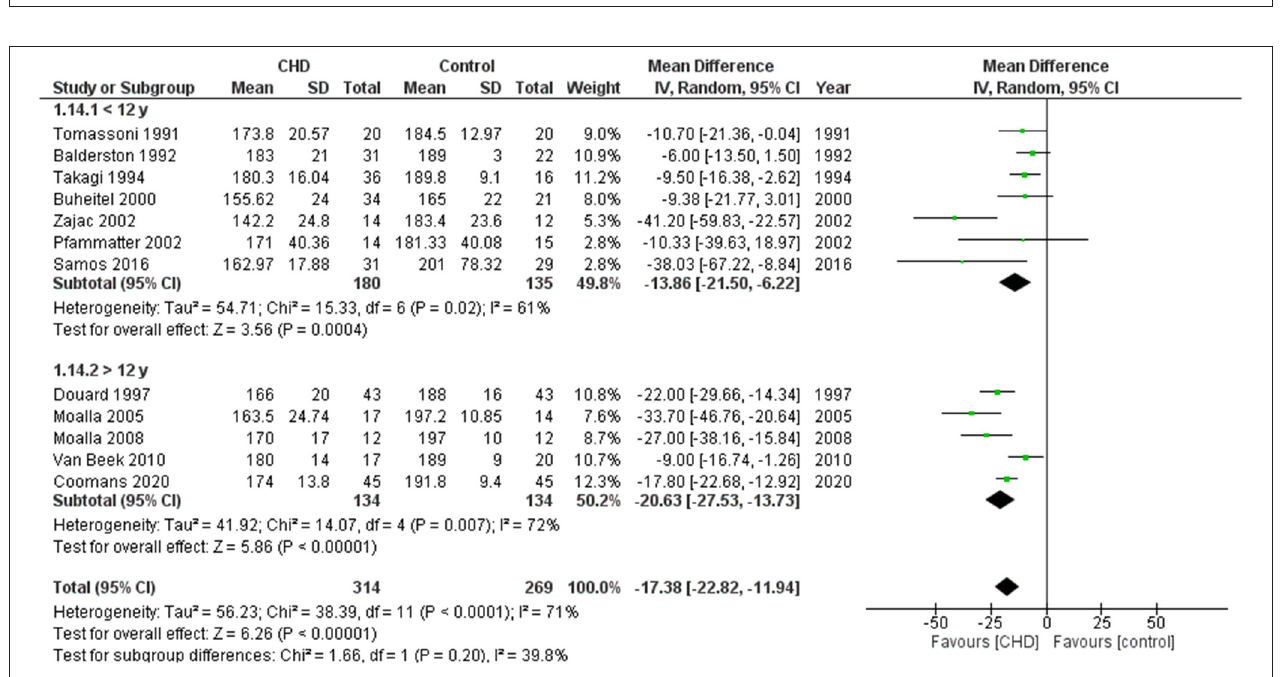
FIGURE 9 | Forest plot for maximum heart rate for CHD in children and adolescents and healthy controls. Subanalysis by age.